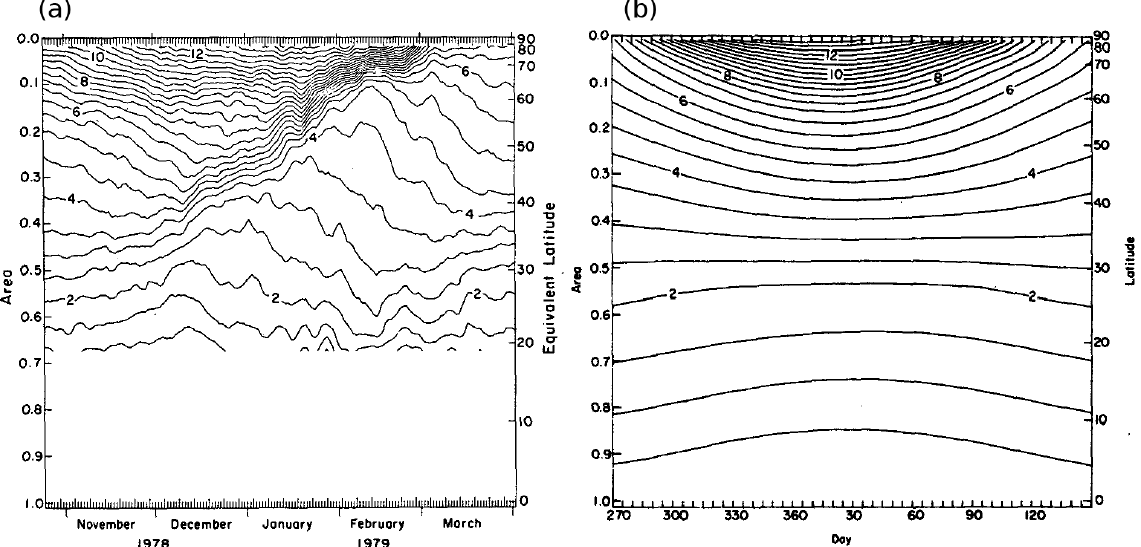
Figure 6. Area enclosed by contours of potential vorticity on the 850K isentropic surface ( ∼ 10hPa) for (a) the 1978/79 NH winter and (b) an idealized simulation of the NH winter in the absence of Rossby waves. Figures 4 and 6 of Butchart and Remsberg (1986), respectively. Details of the calculations and information on the data used can be found in Butchart and Remsberg (1986). ©American Meteorological Society. Used with